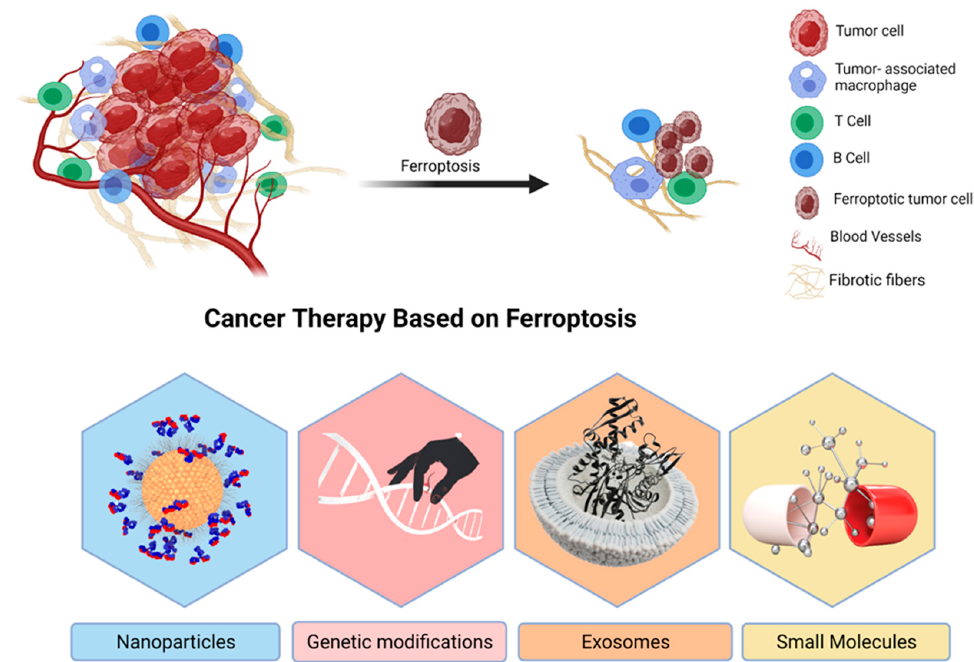
Figure 3. The promising use of ferroptosis for cancer treatment. A representation of ferroptosis-based cancer therapeutics, which includes small chemicals, nanoparticles, exosomes, and gene technology. It is possible to use nanomaterials as drug-inducing ferroptosis and Fe carriers in the chemotherapy combined with hyperthermia and autophagy, etc. Because exosomes are more biocompatible and less immunogenic than nanomaterials, they have a better chance of being used in clinical trials.